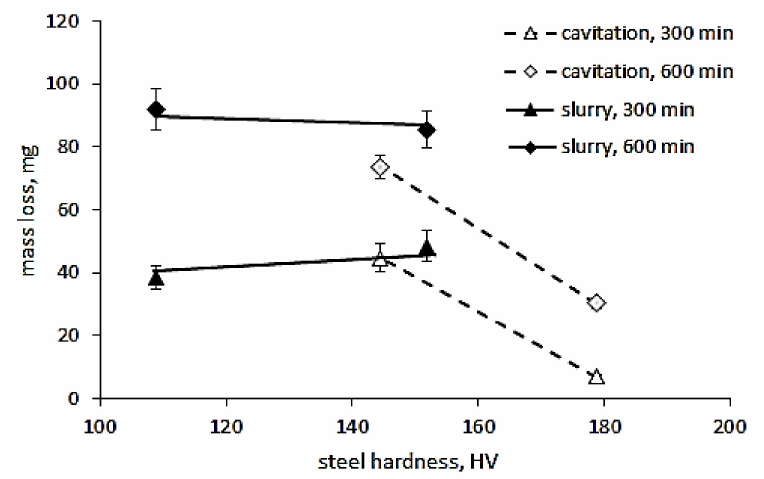
Figure 19. The effect of steel hardness on mass